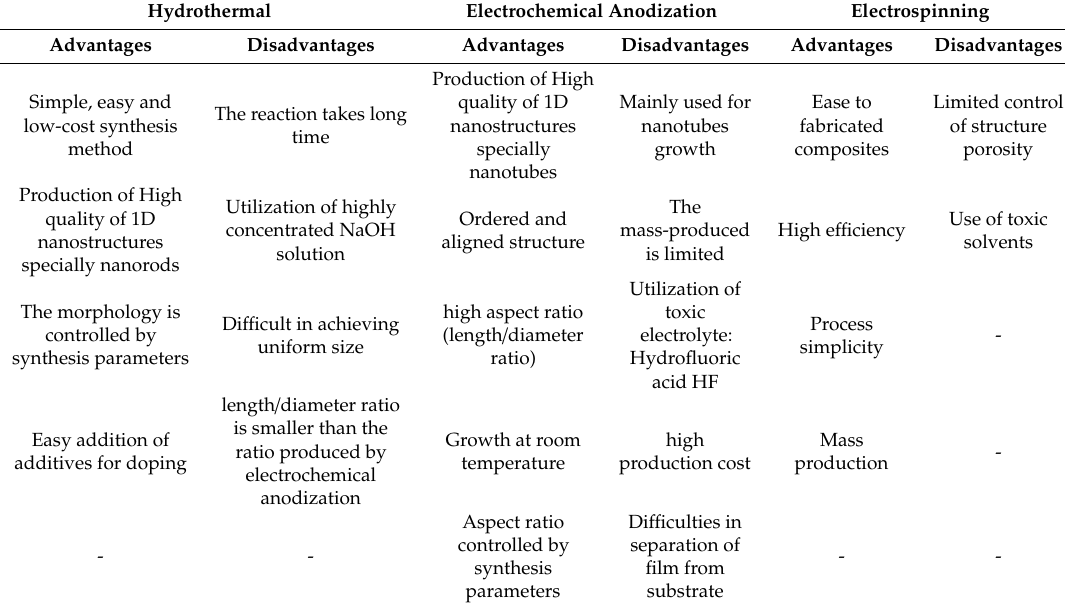
Advantages and disadvantages of hydrothermal, electrochemical anodization and electrospinning